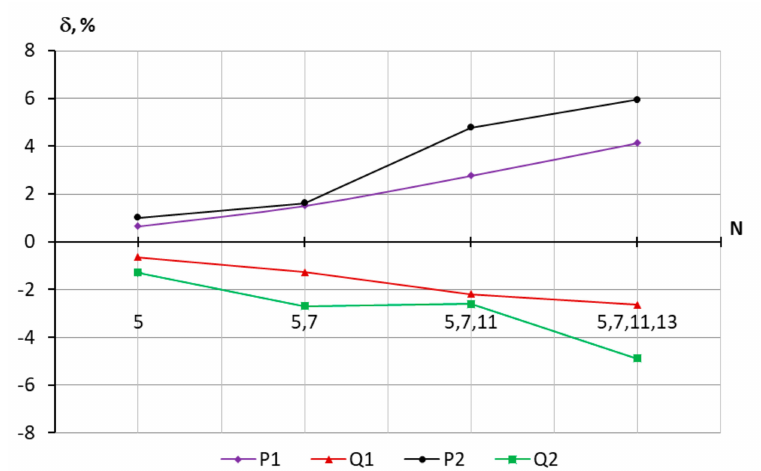
Figure 3. The dependences of the relative metering error for active and reactive power on the number of harmonics, where P1, Q1, P2, Q2—measured values by PM1 and